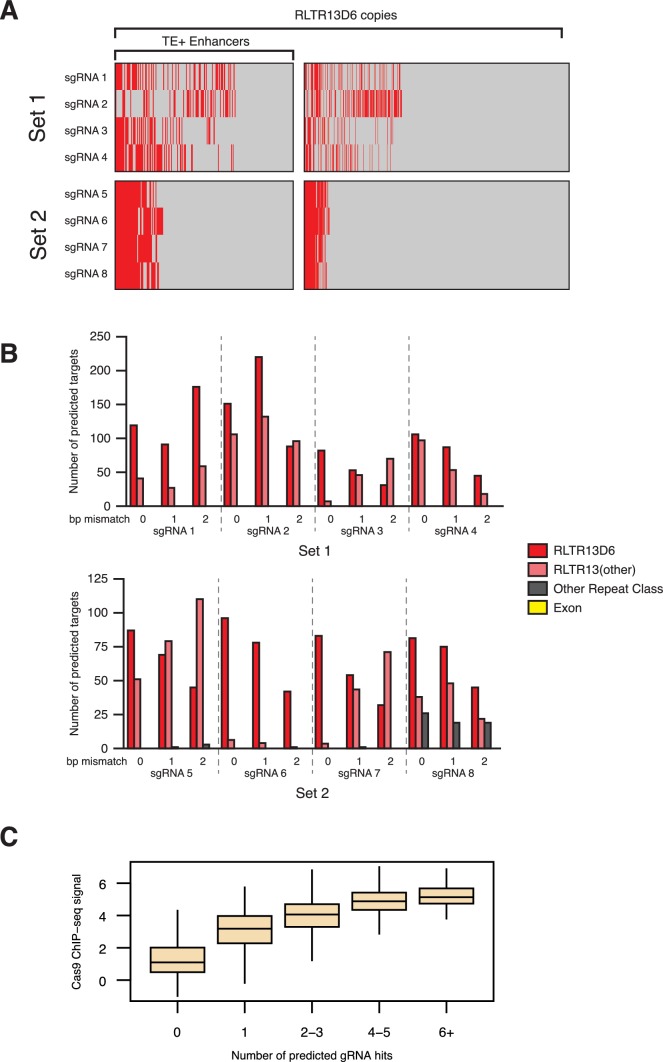
Target predictions for sgRNAs used for CRISPRi.(A) RLTR13D6 copies predicted to be targeted (in red) by each of the sgRNAs in set 1 or set 2, with no mismatches. (B) Off-target predictions for each of the sgRNAs, with either 0, 1 or 2 bp mismatch. Most off-target loci are at related TE subfamilies, and no exons are predicted to be targeted by any of the sgRNAs. (C) Correlation between the number of sgRNAs predicted to bind human LTR5Hs elements and Cas9 ChIP-seq signal from a published CRISPRi experiment (Fuentes et al., 2018).